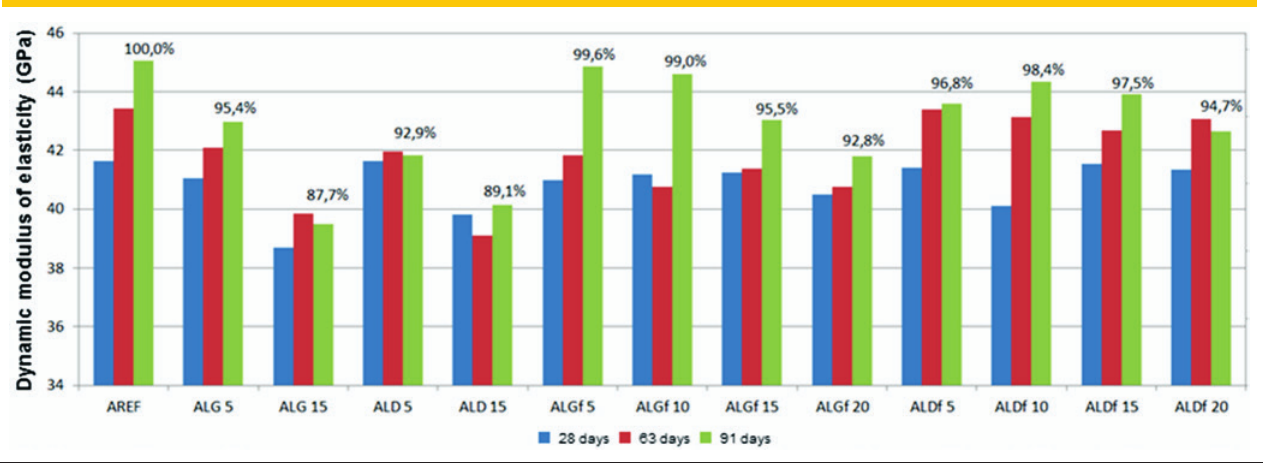
As observed in Figure 7, the mortars with substitution had lower moduli of elasticity, in absolute values, than the MREF, as with the compressive strength. ALGf and ALDf showed modulus of elasticity values closer to the MREF values. At 91 days, the